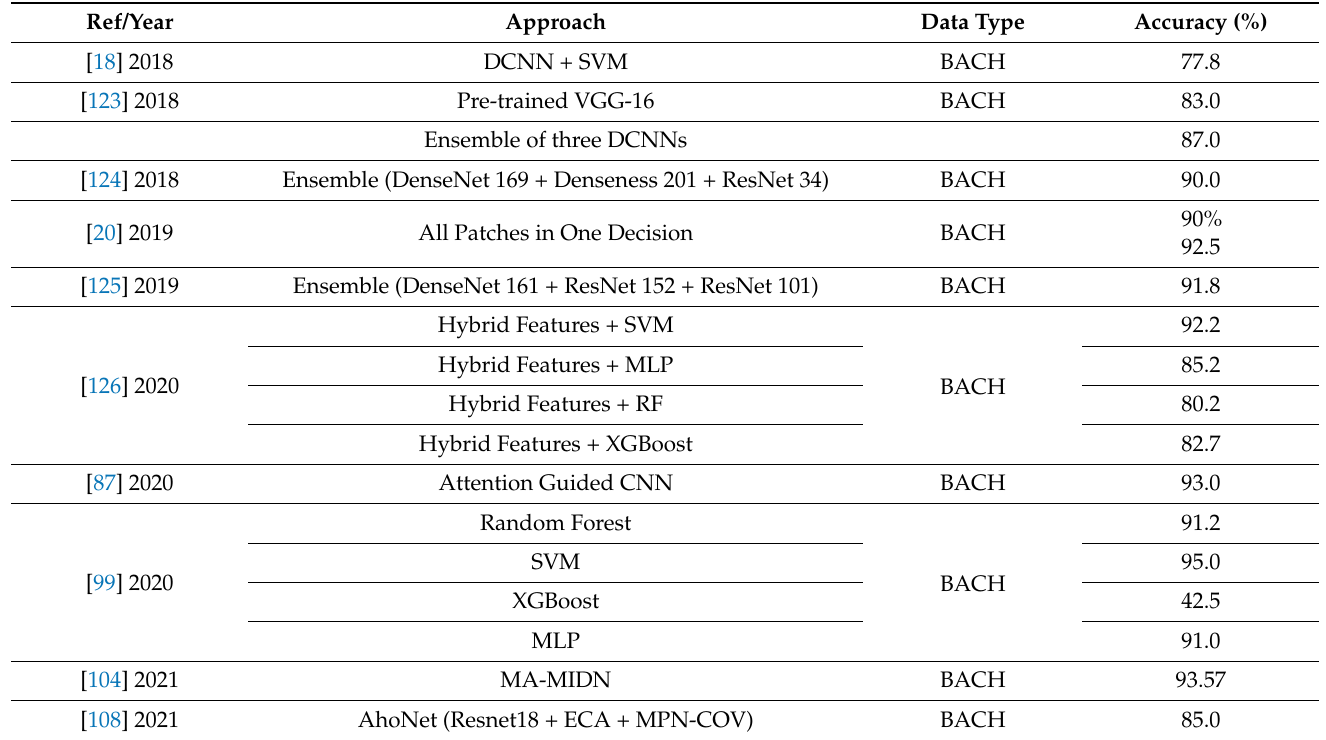
Table 11. Result comparison with the state-of-the-art result using the ICIAR 2018